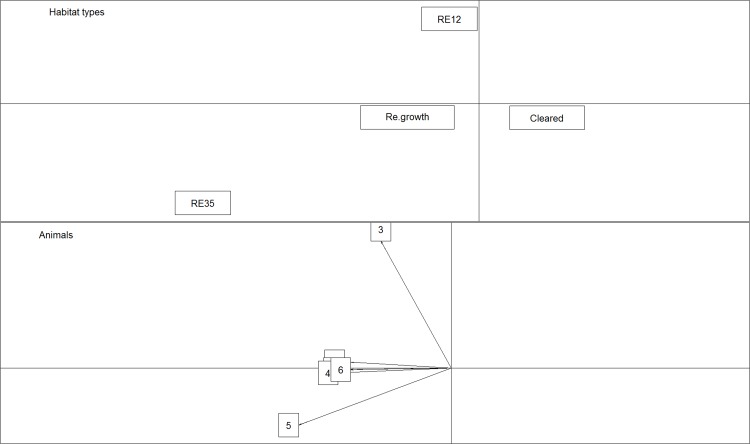
Results of the eigenanalysis of selection ratios to evaluate habitat selection for BTF in Site 1.The top figure shows the habitat types. The bottom figure shows habitat preference of each individual monitored.